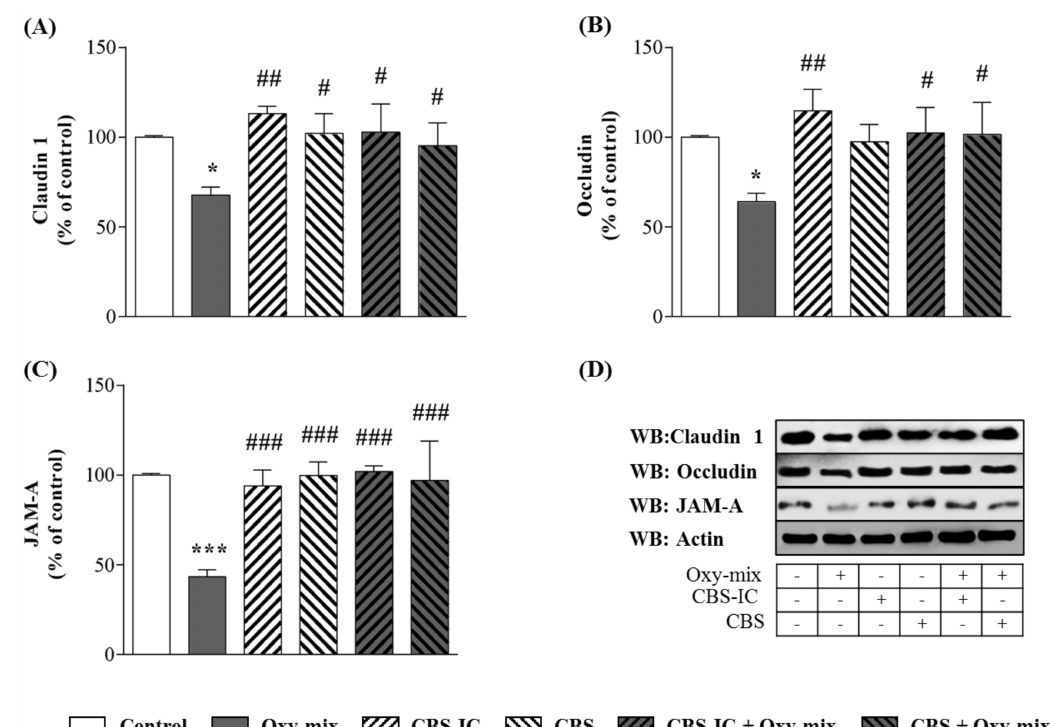
Figure 2. CBS and CBS-enriched ice cream prevented TJ loss induced by Oxy-mix. Decreased levels of claudin 1 ( A ), occludin ( B ) and JAM-A ( C ) were detected by Western Blotting in lysates from CaCo-2 cells incubated with 60 µ M Oxy-mix for 24 h. One-hour CBS or 4% CBS-enriched ice cream (CBS-IC) pretreatment protected oxysterol-mediated TJ loss. A representative Western Blot of each treatment is shown ( D ). Data are expressed as percentage of control (100%). Values are means ± SD of three independent experiments. Significantly different vs. controls: * p < 0.05, *** p < 0.001; significantly different vs.